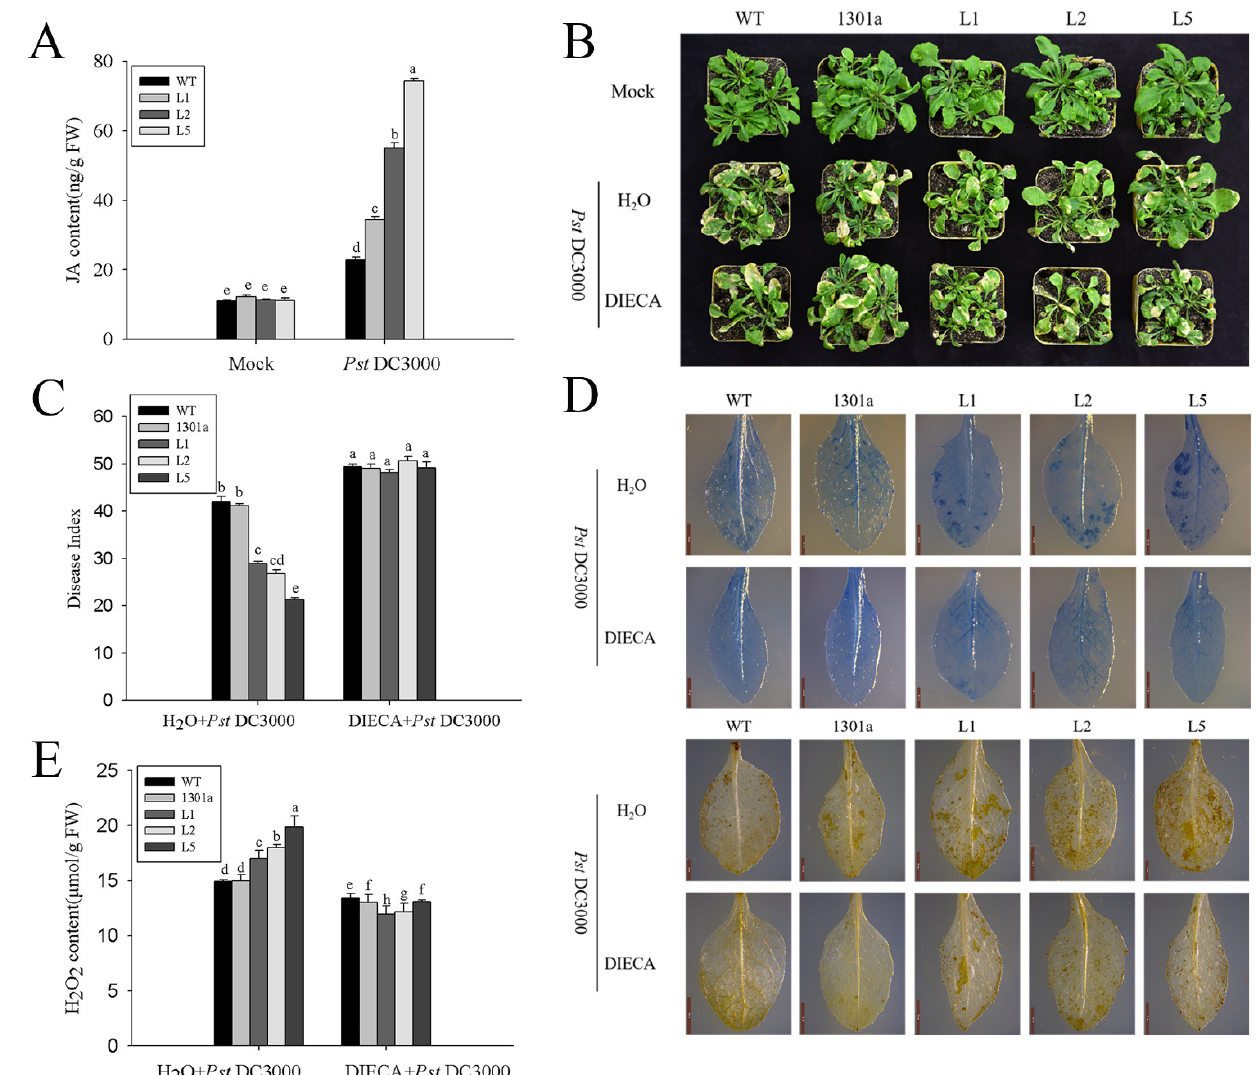
Figure 7. Overexpression of ZmGLP1 in Arabidopsis enhances resistance to Pst DC3000 through the jasmonic-acid-mediated signaling pathway. ( A ) Jasmonic acid contents in the different groups after Pst DC3000 infection. ( B ) Phenotypes of the different groups at 7 d post Pst DC3000 infection, which were pretreated with DIECA for 24 h. ( C ) Disease indexes of the different groups. ( D ) Trypan blue staining and DAB staining of the different groups. ( E ) Detection of H 2 O 2 content of Arabidopsis leaves at 3 d post Pst DC3000 infection in different groups shown in ( B ). Different letters in subfigures ( A , C , E ) indicated significant difference between different samples by Duncan’s post-hoc test.Data are presented as the mean ± SD based on three biological replicates.